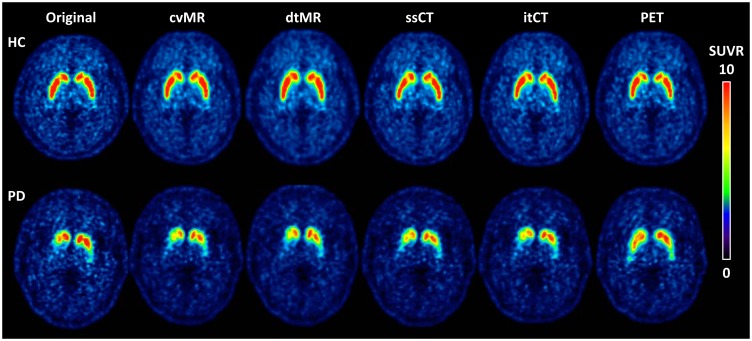
Examples of spatial normalization by five different spatial normalization methods in a healthy control and a PD patient.Four structure-guided spatial normalization methods work well for normalization of PET images, and the PET-guided method also works well in healthy control. However, in PD patient the PET-guided method stretches anterior putamen posteriorly to fill the posterior putamen during the non-linear spatial normalization. Color bars are scaled in standardized uptake value ratio (SUVR). Abbreviations: cvMR = MR-guided spatial normalization with conventional normalization tool, dtMR = MR-guided spatial normalization with DARTEL toolbox, ssCT = skull-stripped CT-guided spatial normalization, itCT = intensity transformed CT-guided spatial normalization, PET = PET-guided spatial normalization.